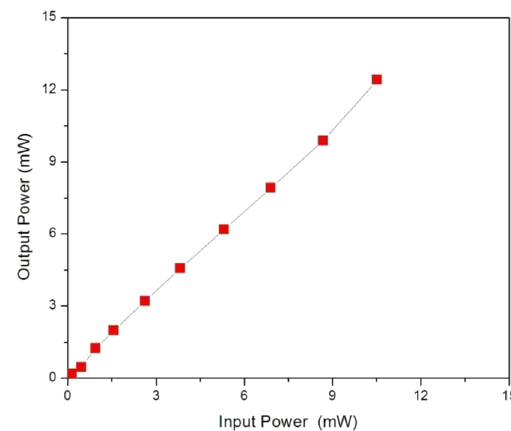
Figure 4. Optical Limiting Plot.